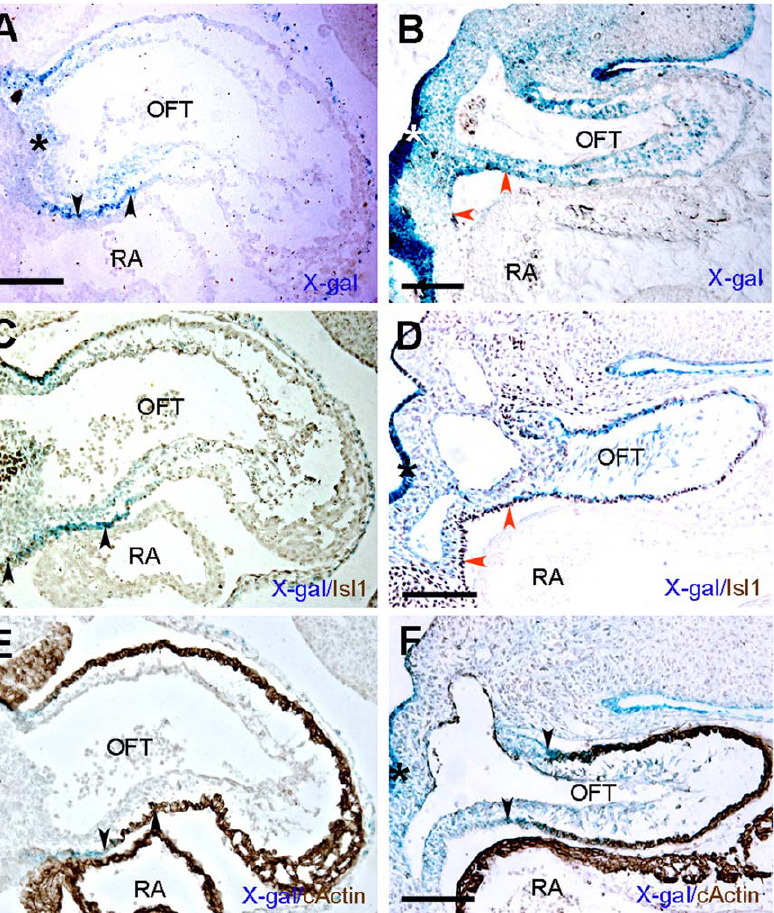
Figure 5. b -gal, Islet-1 and cardiac actin expression in the hearts of transgenic embryos at E9.5 and E10.5. Transverse (A, C, E) and sagittal (B, D, F) sections of E9.5 and E10.5 transgenic embryos, respectively. (A) The X-gal-stained cells in the outer layer of the outflow tract also express Isl1 (C, arrowheads). Only transgenic cells in the distal outflow tract (delineated by arrowheads in A) express c-actin (E, arrowheads). Note that dorsal part of the developing aortic sac (asterisk in A) is filled with Isl1-expressing cells. (B) X-gal-stained cells are present in the outflow tract region and anterior portion of SHF demarcated by the red arrowheads. (D) Isl1-immunostained cells are present in this anterior portion of SHF (demarcated by the red arrowheads) and outflow myocardium, whereas c-actin is restricted to myocardial transgenic cells of the outflow tract (F, arrowheads). OFT, outflow tract. Black and white asterisks in (A) and (B) show the aortic sac and pharyngeal endoderm, respectively. Scale bars=100 m m.